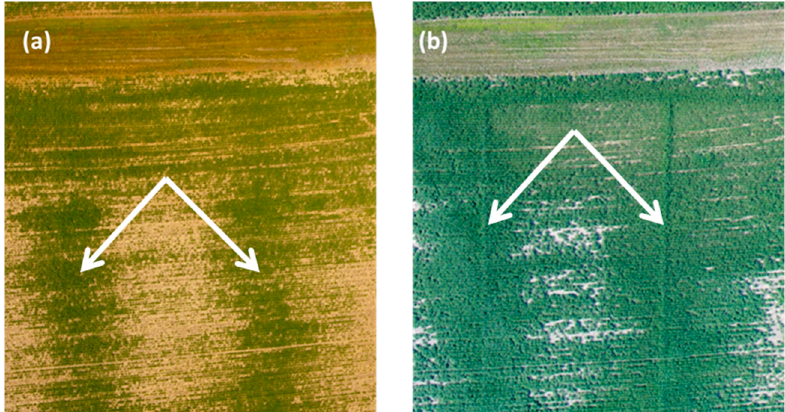
Figure 9. ( a ) Showing optical image collected on 15 July 2019 ( b ) optical image collected on 6 Au- gust 2019. White arrows indicating the location of tile lines. 6 August 2019. White arrows indicating the location of tile